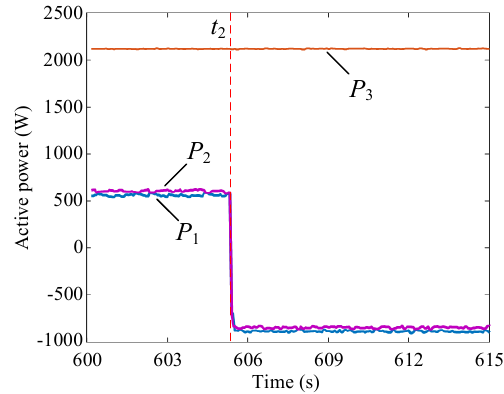
Figure 10. Active power waveforms of microgrid at Case